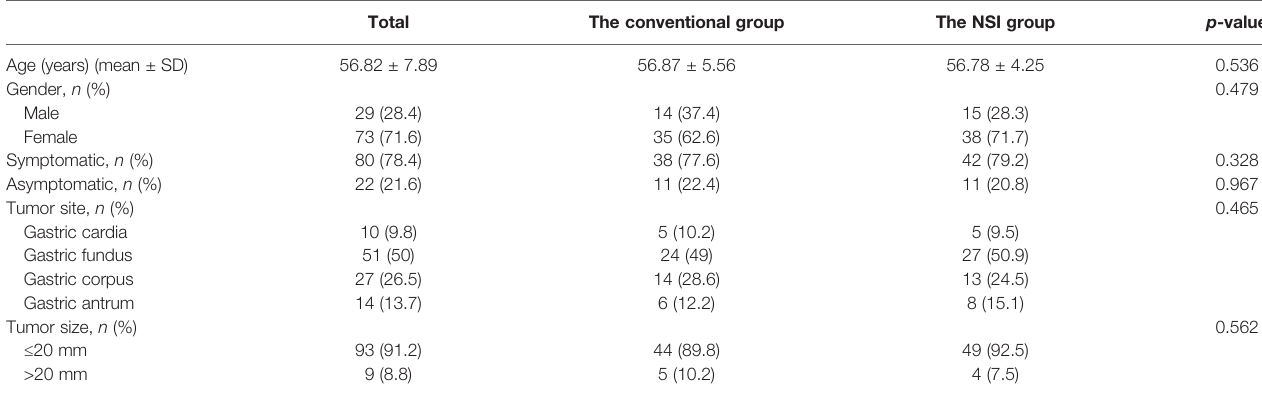
TABLE 1 | Characteristics of the patients and GISTs. Total The conventional group The NSI group p